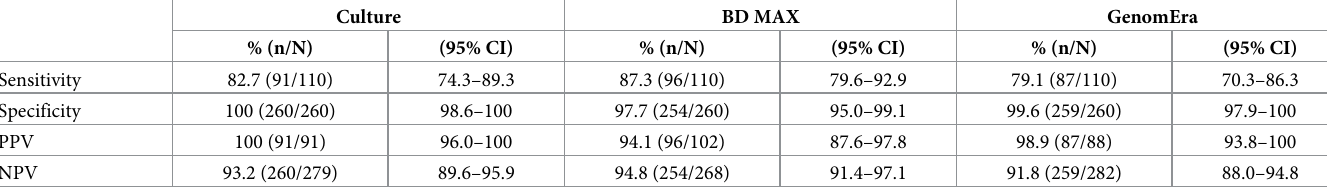
Table 5. Performance characteristics of culture and PCR assays with the combined standard as reference.